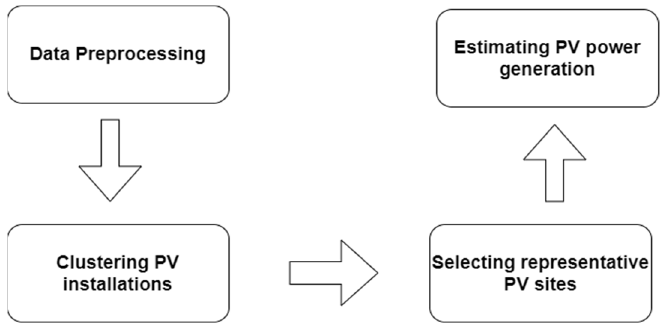
Figure 1. The proposed methodology.